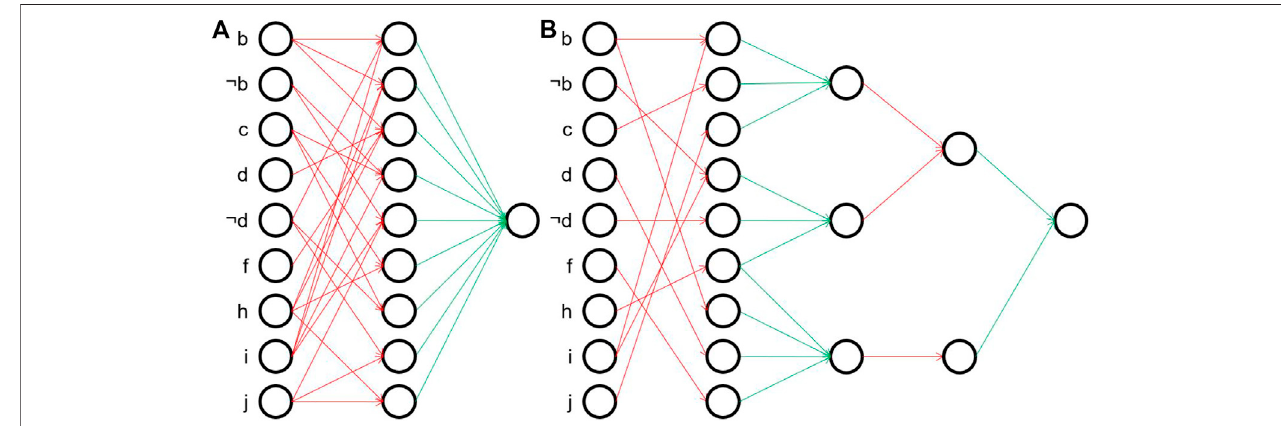
FIGURE4| Examplenetworksof Eq.2 , 3 .Forabetteroverview,theinputnodes notin fl uencing the fi nalconceptareremoved.RedconnectionsarelogicalANDs, green edges correspond to logical ORs. (A) Shallow example. (B) Deep example.